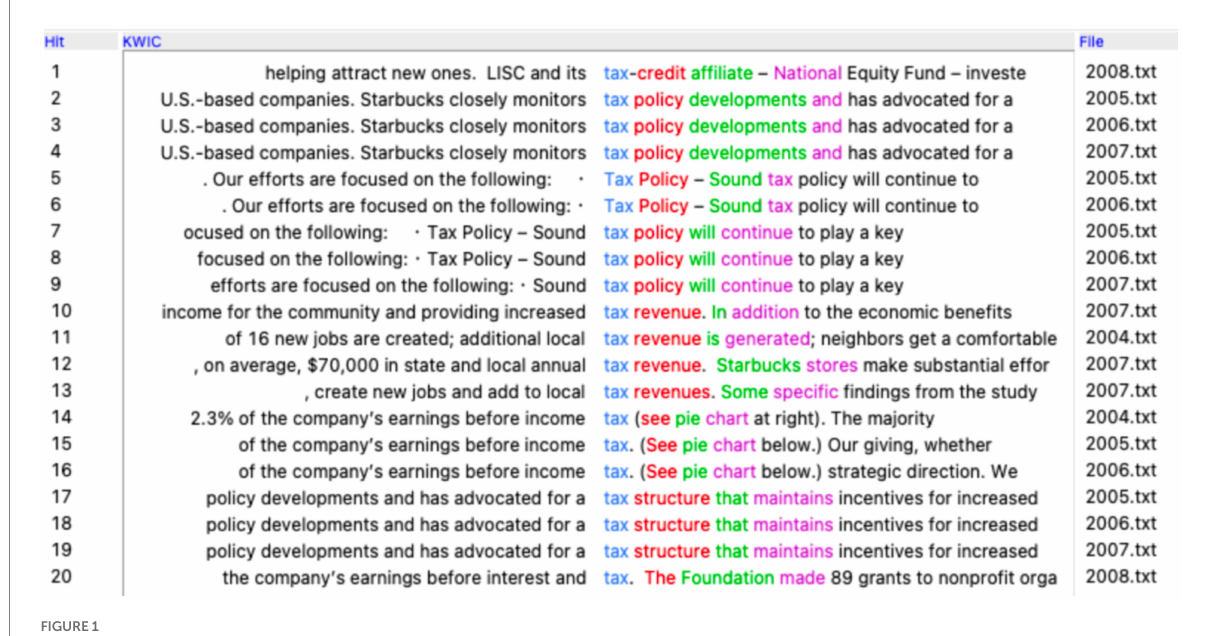
FIGURE 1 Concordance lines of ‘tax’ in Starbucks’ CSR reports. Reproduced from Antconc (Anthony,